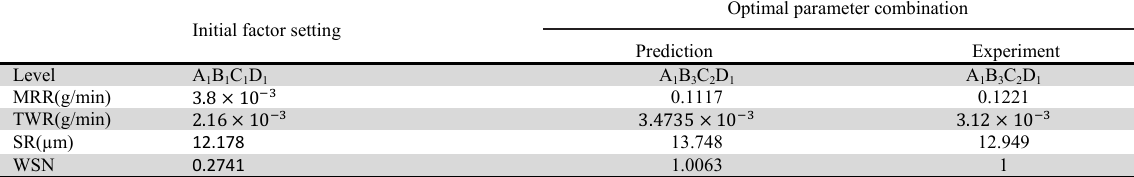
Results of the confirmatory experiment for WSN ratio method